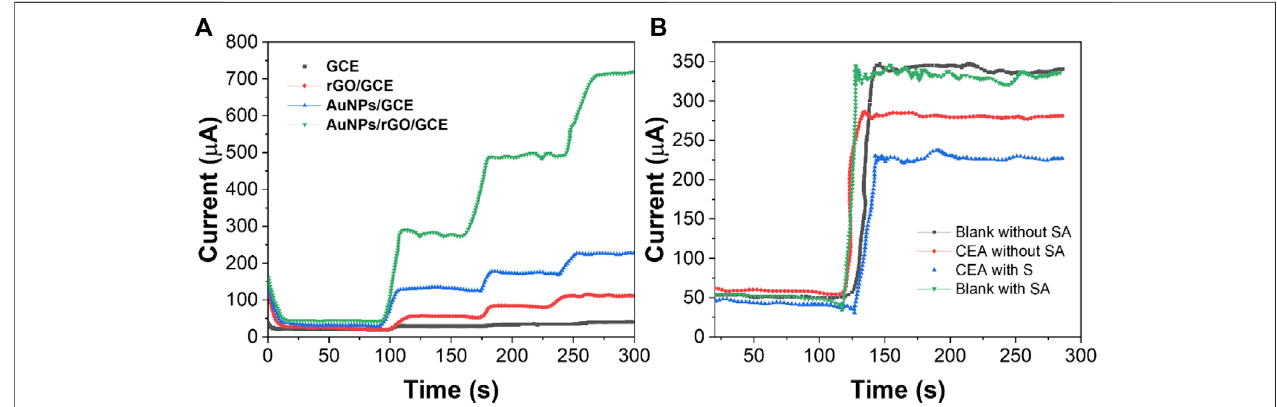
FIGURE 6 | (A) i-t curves of GCE, AuNPs/GCE, rGO/GCE, and AuNPs/rGO/GCE. (B) i-t curves of the immunosensor modi fi ed with or without SA.